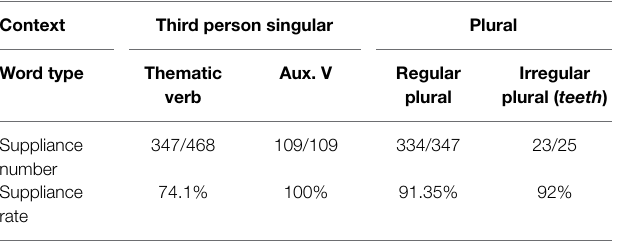
TABLE 4 | Suppliance in all 3SG and plural markings in the written translation